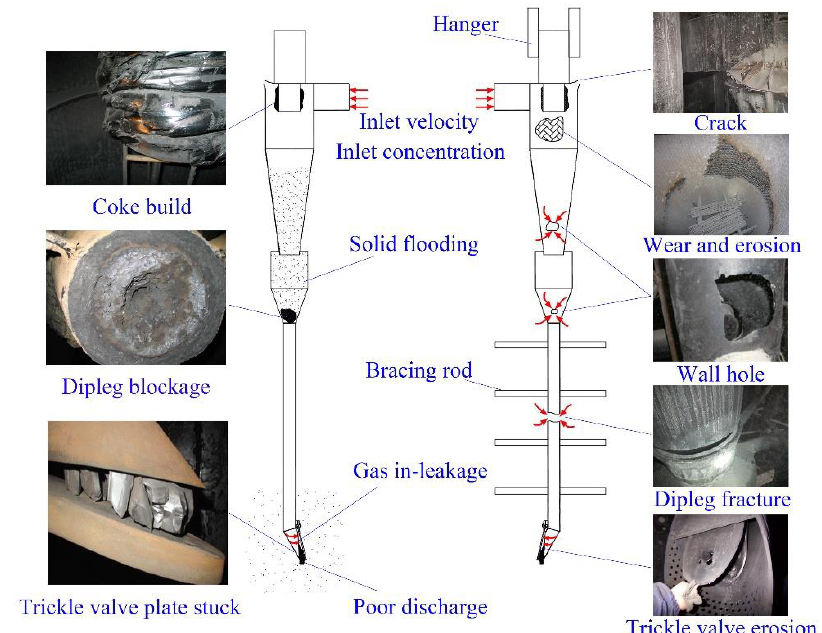
Figure 3. Factors of catalyst loss in the cyclone